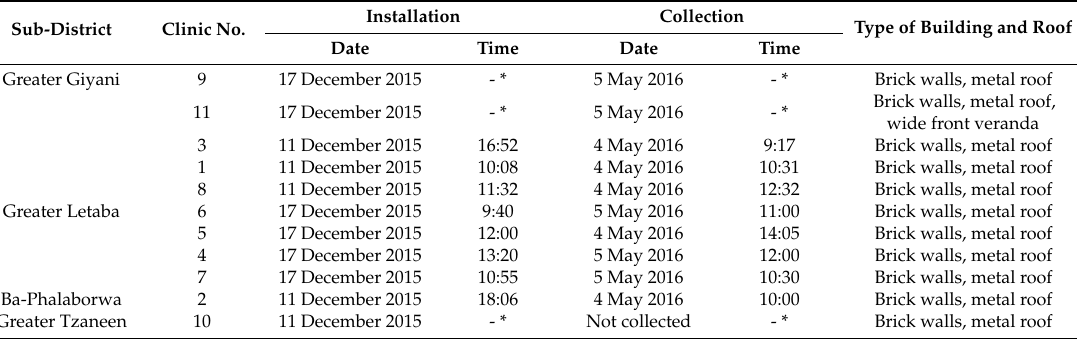
Table 1. Clinic location in sub-district and installation and collection date and time, as well as type of building and roof of each clinic. Clinic